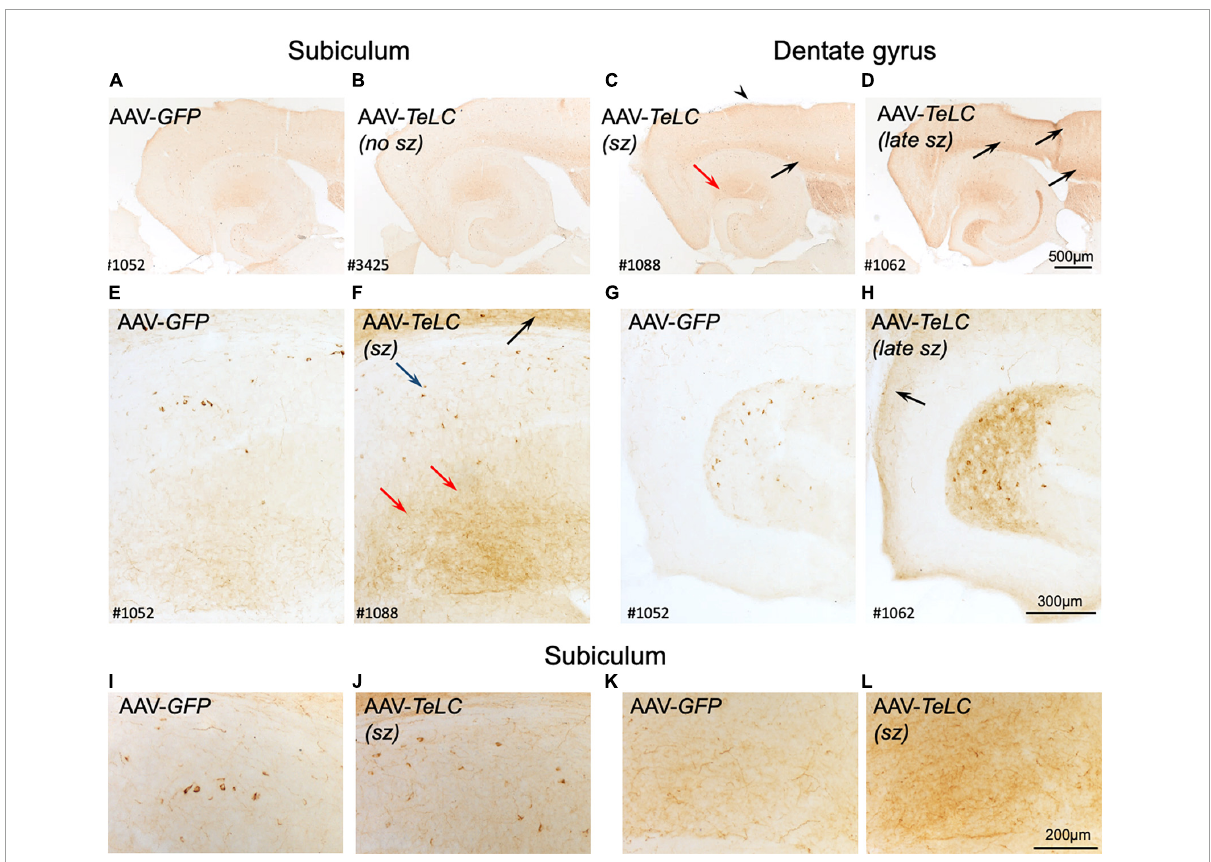
FIGURE3 Expression of NPY-IR in the cortical areas, the subiculum and in the dentate gyrus 42 days after vector injection. Panels (A,E,G) show images from horizontal sections at the level of the of the ventral subiculum/hippocampus obtained from an AAV- GFP -injected mouse and show basal NPY expression. Panel (B) is taken from an AAV- TeLC -injected mouse without spontaneous seizures. In panel (C) , a mouse that had experienced 5 seizures between days 16 and 29 is shown (“sz”; see Figure 1A ). Slightly increased expression of NPY-IR is seen in the outer molecular layer of the subiculum, in cortical layers [black arrows in panels (C,D,F) ] and in hilar interneurons. Panels (D,F,H) derive from an AAV- TeLC -injected mouse that had experienced seven SRS during days 30–42 after vector injection (last 12 days before sacrificing, “late sz”). Note the pronounced increases in NPY-IR in cortical areas [arrows in panels (D,F,H) ], in interneurons (blue arrow) and their fibers (red arrows) in the molecular layer of the subiculum (D,F) , and in interneurons and their fibers in the hilus of the dentate gyrus (H) ; compare AAV- GFP -injected control (G) . Note that NPY-IR is lastingly up-regulated, both in interneurons and axon terminals of the subiculum [blue and red arrows in panel (F) ] and of the dentate hilus (H) . Furthermore, panels (I–L) show larger magnification aspects of the subiculum highlighting the seizure-induced increased number of NPY-positive interneurons (J) and fibers (L) after AAV- TeLC injection compared to AAV- GFP -injected controls (I,K) . Numbers (#) in the left lower corners of the images refer to numbers of individual animals; the time course of their seizure spells and of IS clusters is shown in Figure 1A . sz, seizures between days 16 and 29 (seizure-free for last 13 days before sacrificing; sz +, strong seizures within 12 days before sacrificing.